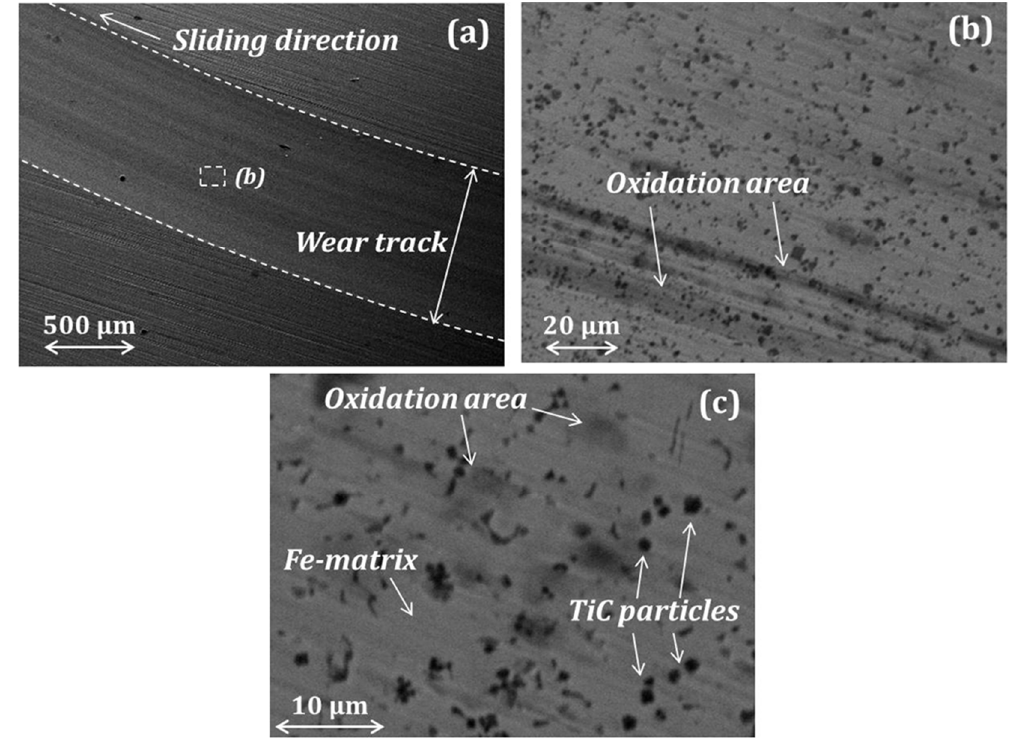
Figure 14. Top view SEM micrographs of the worn surface of the FCAW hardfacing layers, after ball-on-disk testing for 200,000 sliding revolutions, applying a normal load of 10 N: ( a ) entire width of the wear track, ( b ) and ( c ) successive magnifications within the wear track, demonstrating extensive oxidation and abrasion scars along the sliding direction.